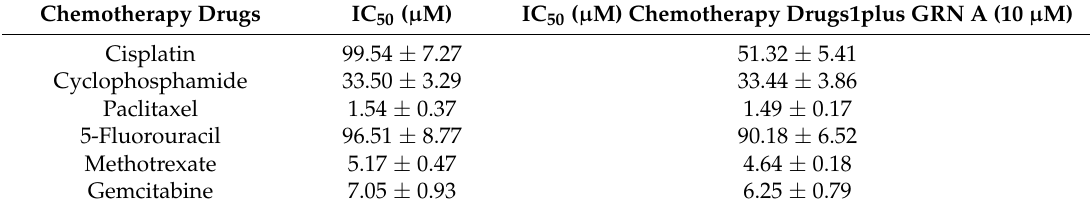
Table 1. Granulin A (GRN A) enhanced the cytotoxicity of cisplatin in HepG2 cells. Cells were treated with cisplatin, cyclonphosphamide, paclitaxel, 5-fluorouracil, methotrexate, and gemcitabine, respectively, in the presence or absence of GRN A. After being treated for 48 h, the cell viability was determined by MTS assay, and IC 50 values were calculated using SPSS10.0